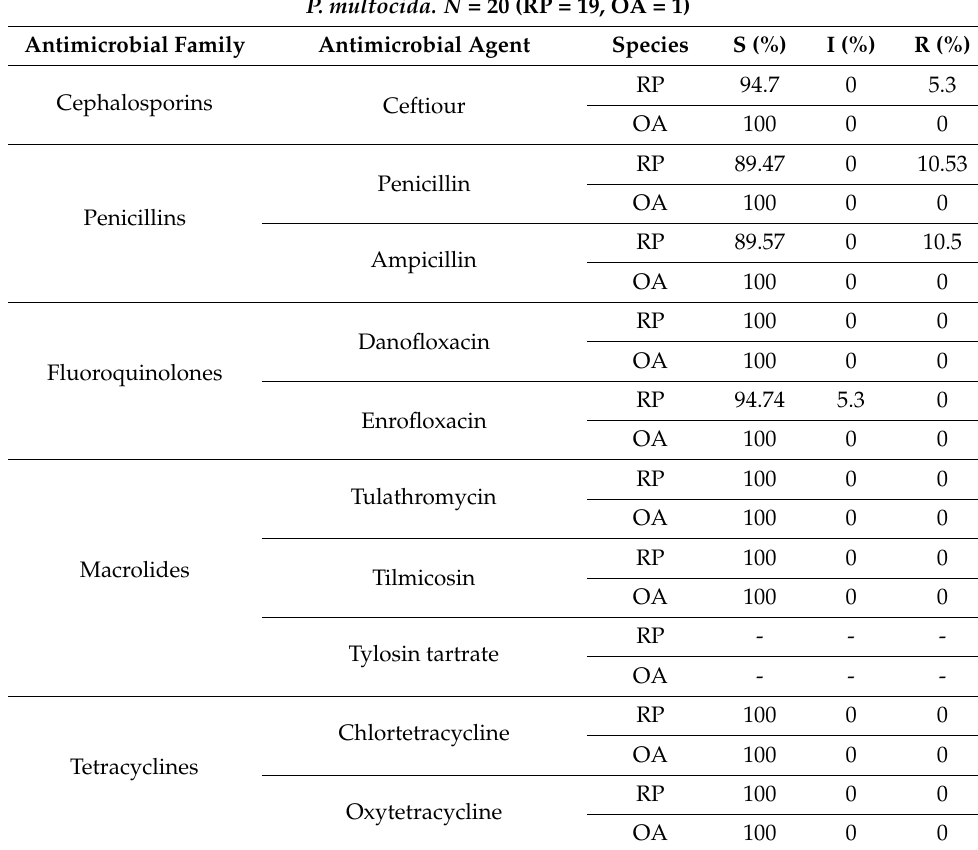
Table 2. Number of Pasteurella multocida isolates found in chamois and domestic sheep, classified as susceptible (S), intermediate (I) or fully resistant (R) to the antibiotics tested. We considered that AMR was present if an isolate showed intermediate or total resistance to a specific antimicrobial family, following MIC criteria from CLSI guidelines. Considered antibiotics are ceftiofur, penicillin, ampicillin, danofloxacin, enrofloxacin, tulathromycin, tilmicosin, chlortetracycline, oxytetracycline, spectinomycin and